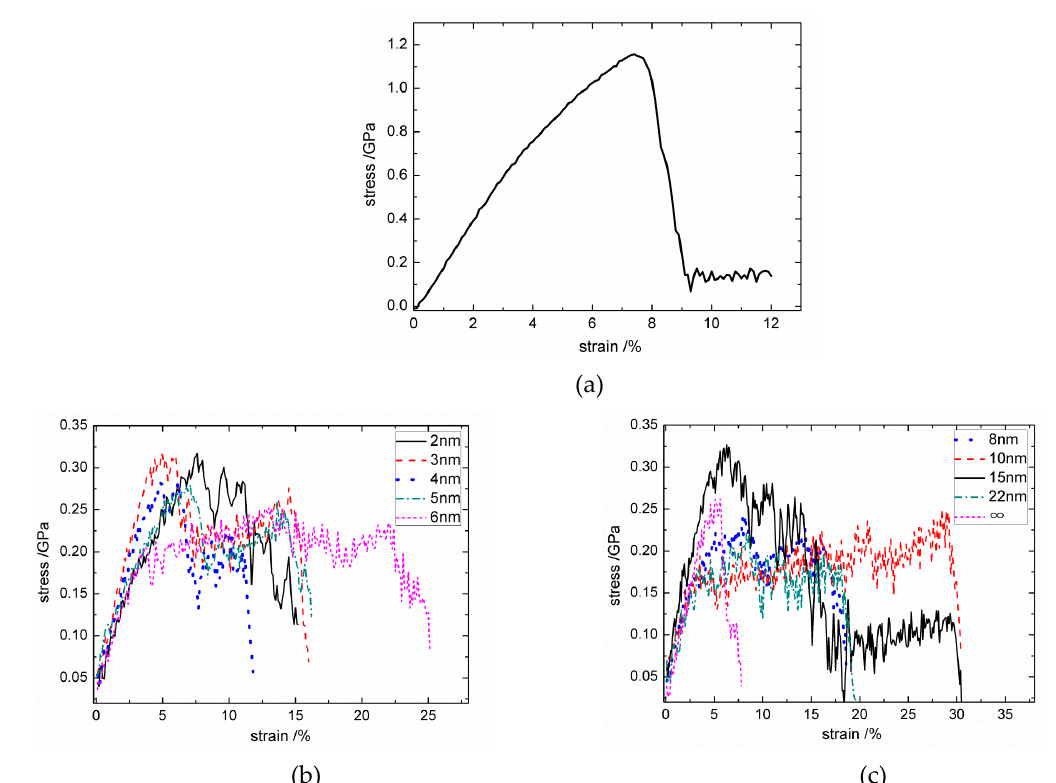
Figure 5. Typical normal tensile stress–strain curves: ( a ) perfect hexagonal graphite; ( b ) the C f /PyC interphase with L a equal to 2–6 nm; ( c ) the C f /PyC interphase with L a equal to 8 nm- ∞ .